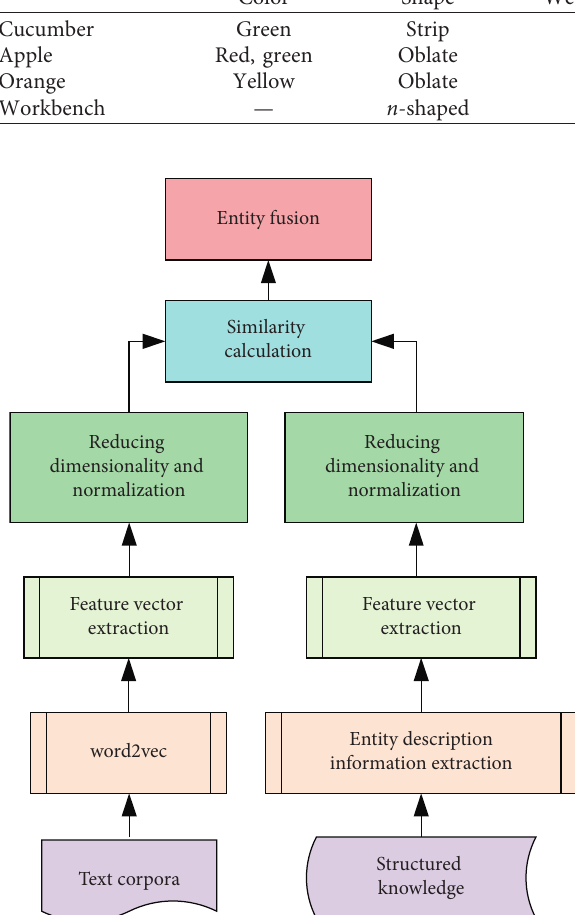
Figure 10: Flowchart of multimodal semantic